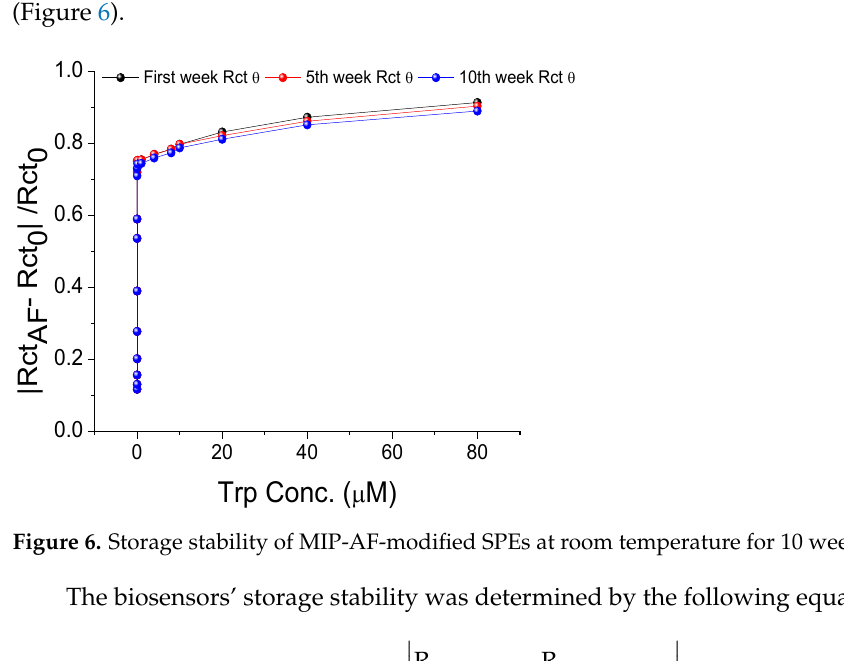
Figure 5. ( a ) Adsorption isotherms of Trp (1–120 µ M) on MIP-AF (red) and NIP-AF(black). Amount of MIPs or NIPs: 1 mg mL1; volume: typically 1.0 mL; time: 1 h. The three measures’ means are shown by the dots. ( b ) Adsorption kinetics of Trp on MIP-AF and NIP-AF.